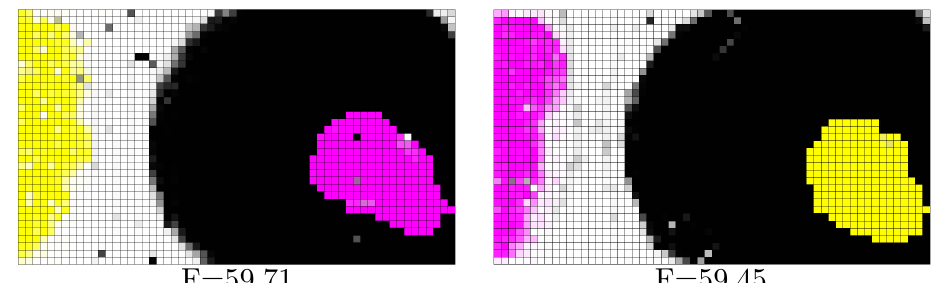
Figure 24. Optimized topologies.